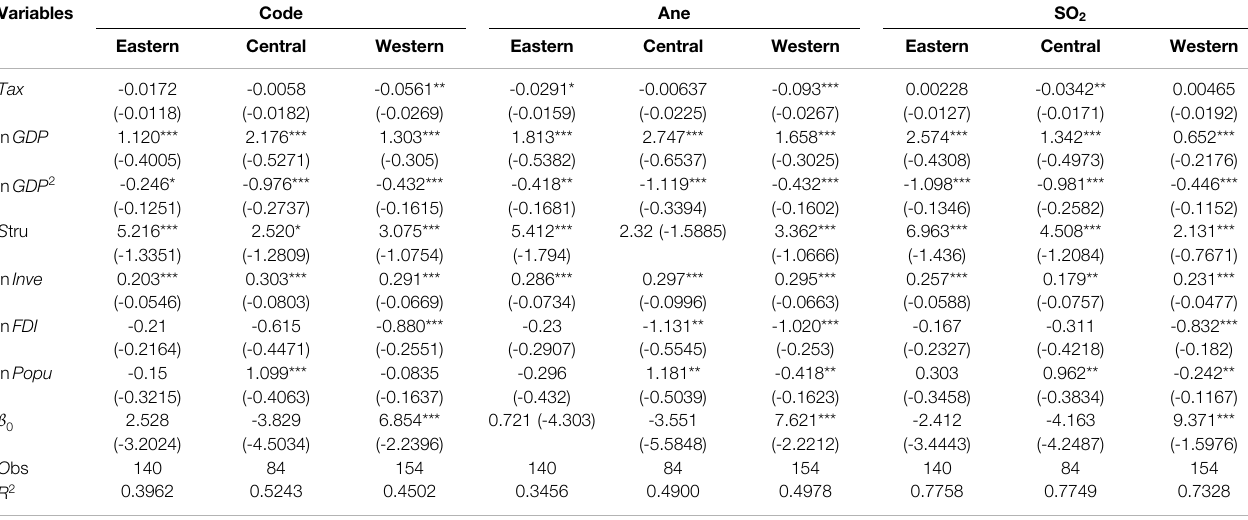
TABLE 3 | Empirical results of environmental taxes and fees and three types of pollutant emissions in 30 prov-inces and cities in China. Variables